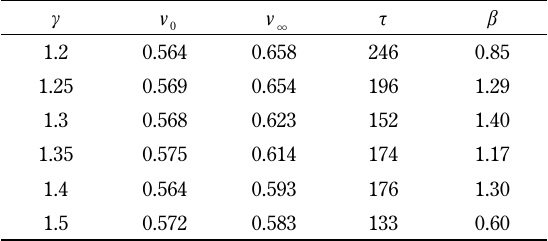
Table 2. Fitting parameters for stretched exponential